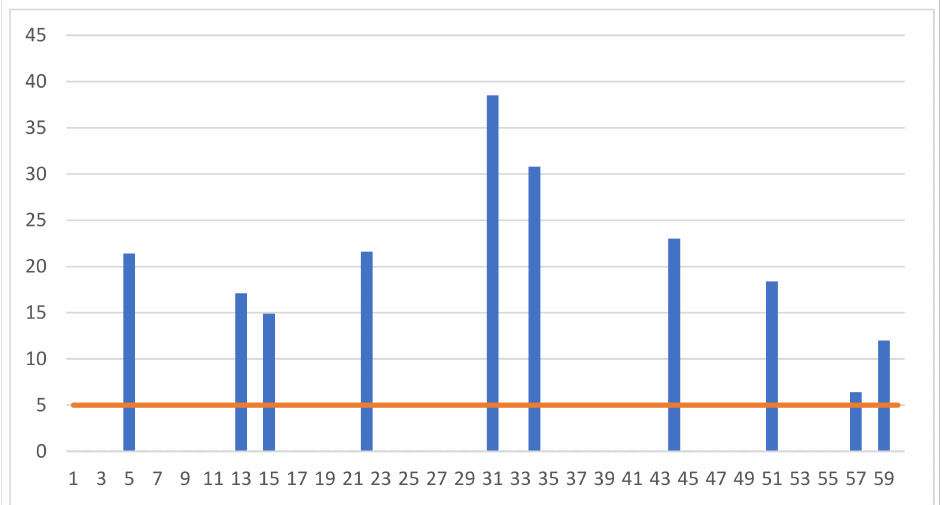
Figure 2. Individual results of measuring the concentration of luteinizing hormone (LH) (mlU/mL) in the blood of the examined